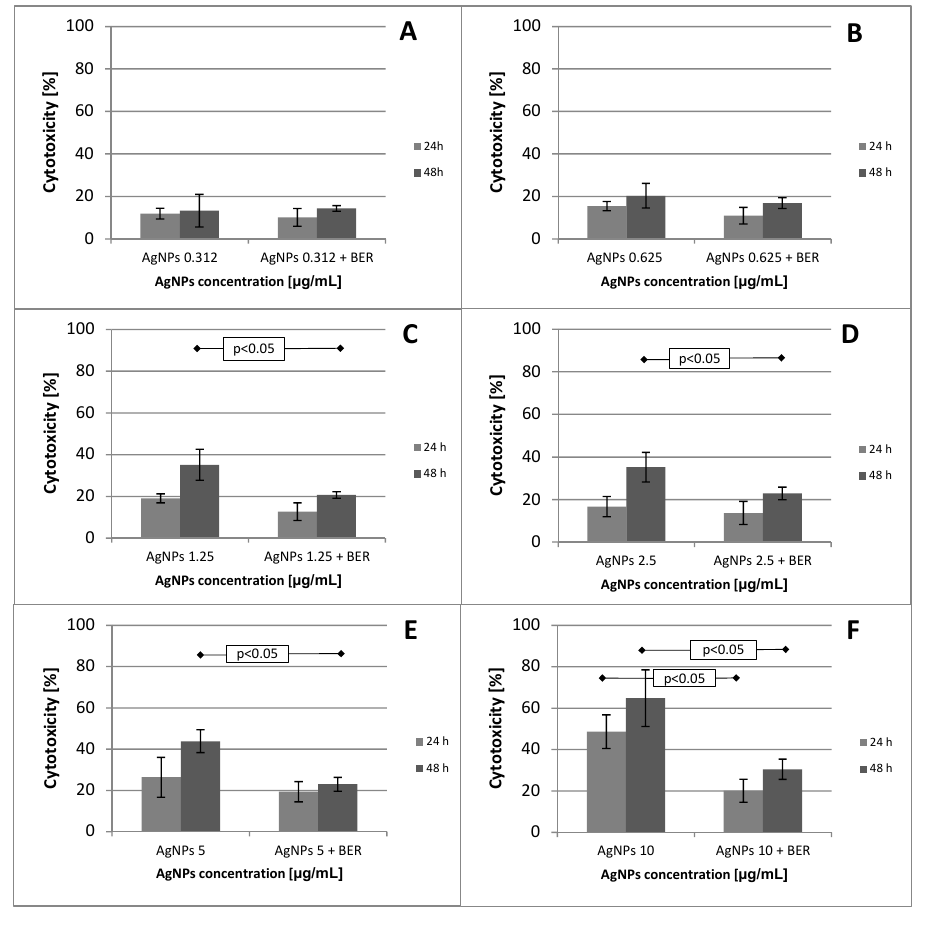
Figure 2. MTT assay results after 24 and 48 h of cells culture incubation representing mean values for different concentrations of AgNPs alone and in combination with a fixed 1/2 IC 50 (12.5 μ g/mL) concentration of BER. AgNPs with BER inhibited significantly less the growth of SCC-25 in a